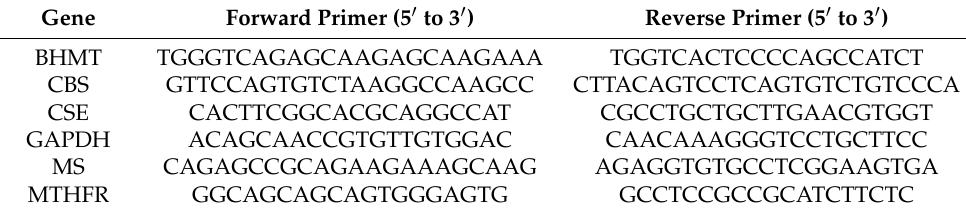
Table 5. Oligonucleotide primers used in this study (sp. Gallus gallus ).